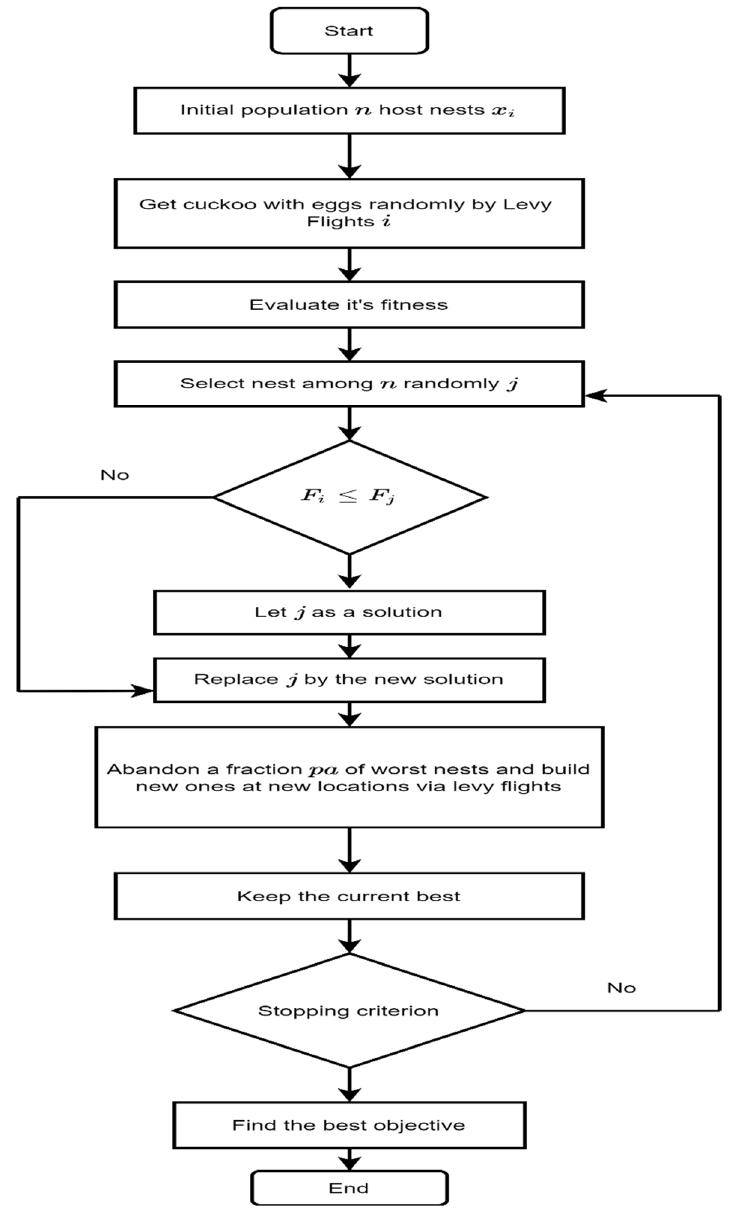
Figure 10. Framework of the standard Cuckoo Search (CS) Algorithm.